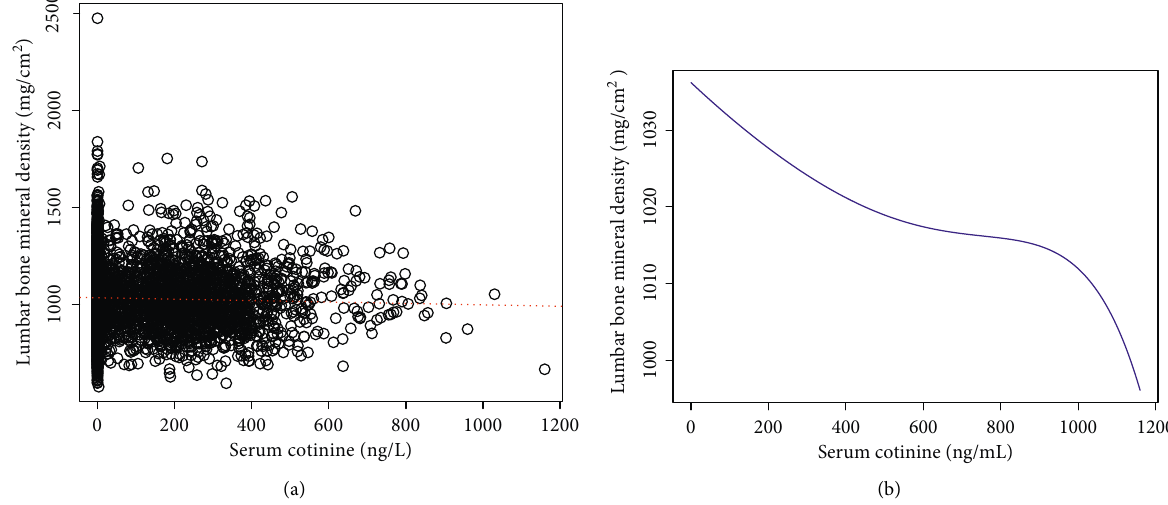
Figure 1: The association between serum cotinine and lumbar bone mineral density. (a) Each black point represents a sample. (b) Smooth curve fit between serum cotinine and lumbar bone mineral density. Age, gender, race/ethnicity, education, body mass index, physical activity, serum albumin, blood urea nitrogen, serum uric acid, serum calcium, and serum phosphorus were adjusted.